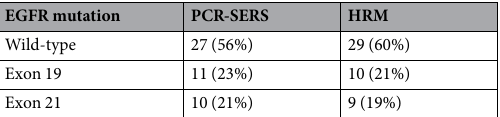
Table 3. EGFR mutation predicted by PCR-SERS and HRM in 48 patients with